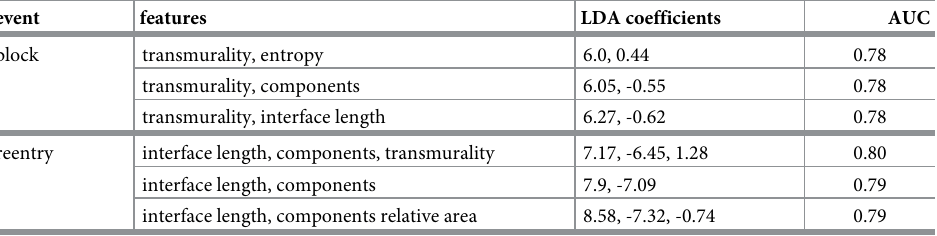
Table 2. The top 3 best combinations of 2-3 LGE features obtained from Fisher’s linear discriminant analysis (LDA) for predicting block or reentry in one more simulations for a given image. All features were max-min nor- malized to the range 0-1. Coefficients are the weight values assigned by the LDA to each normalized feature. AUC val- ues are area under the curve from a 20-fold cross validated receiver operating curve analysis whose threshold values (obtained from 1 fold) are the feature linear combinations (obtained from the remaining 19